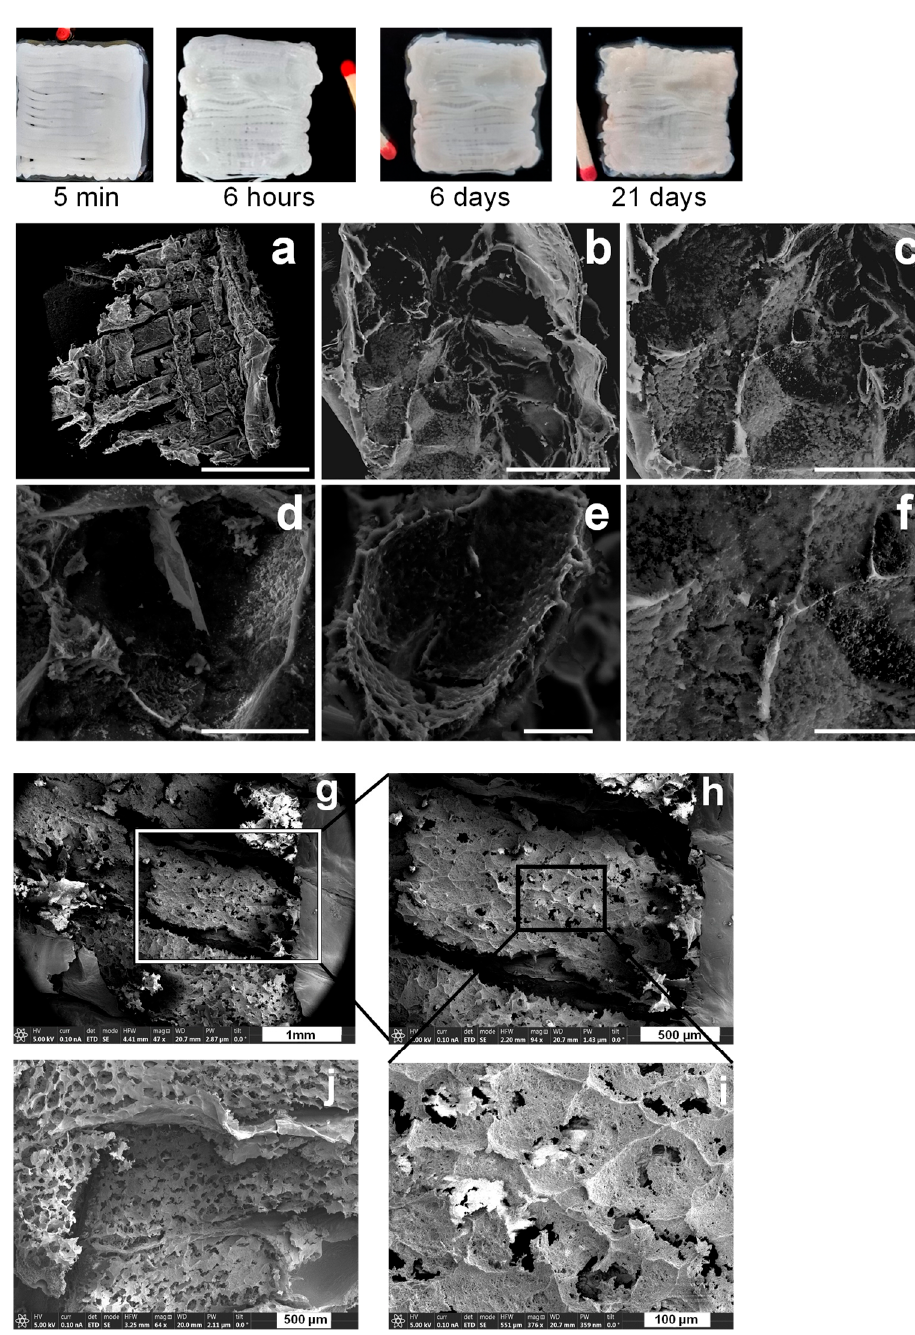
Figure 6. ( Top ) Macroscopic images of 3D printed CHI/CNF/Entrapped-cellulase hydrogel scaffolds evolution after printing and further incubation in PBS (pH 7.4) at 37 °C, allowing sustained CNF enzymatic biodegradation, as shown for different times: 5 min, 6 h, 6 d and 21 d. ( Middle and Bottom ) SEM micrographs of the microstructure of corresponding freeze-dried scaffolds obtained after enzymatic degradation for 21 days ( a – f ) (scale bars: ( a ) 3 mm (overview), ( b ) 200 µ m, ( c , d ) 100 µ m, ( e , f ) 50 µ m) and for 14 days ( g – j ), at different magnifications and filament